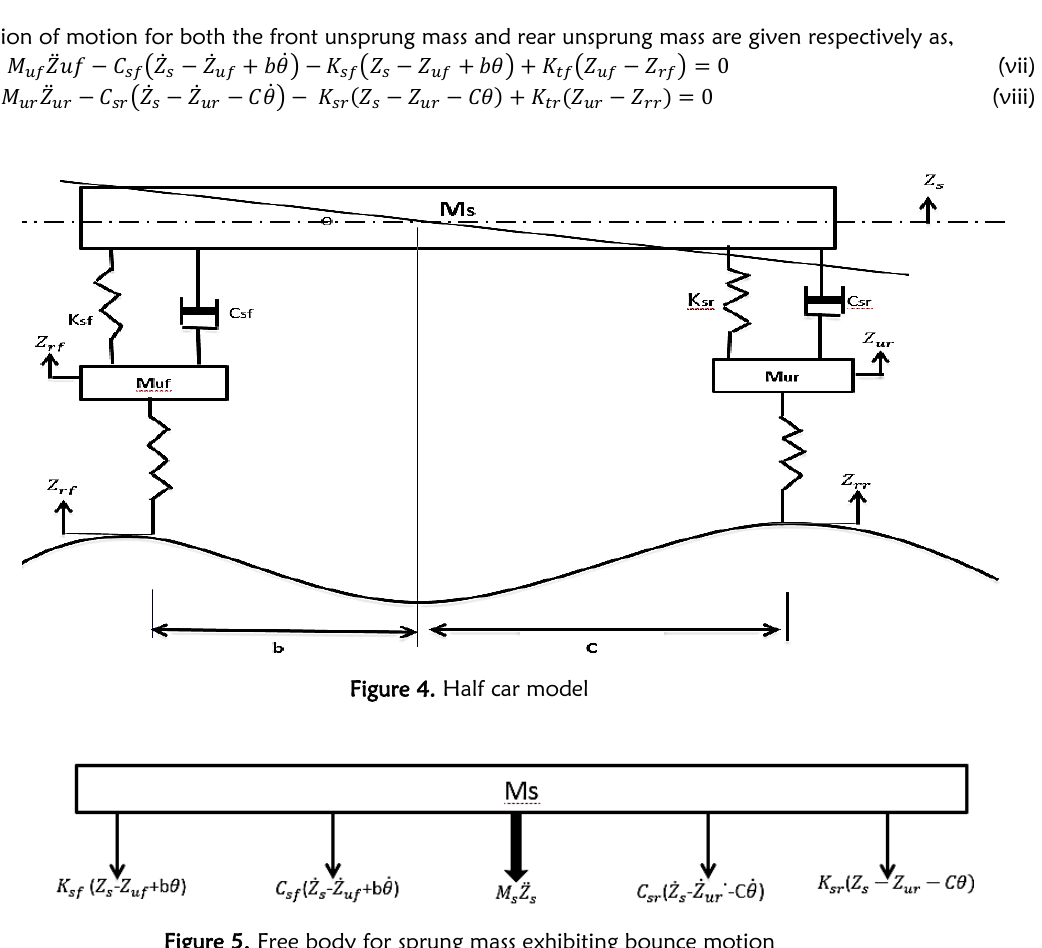
Figure 5. Free body for sprung mass exhibiting bounce motion